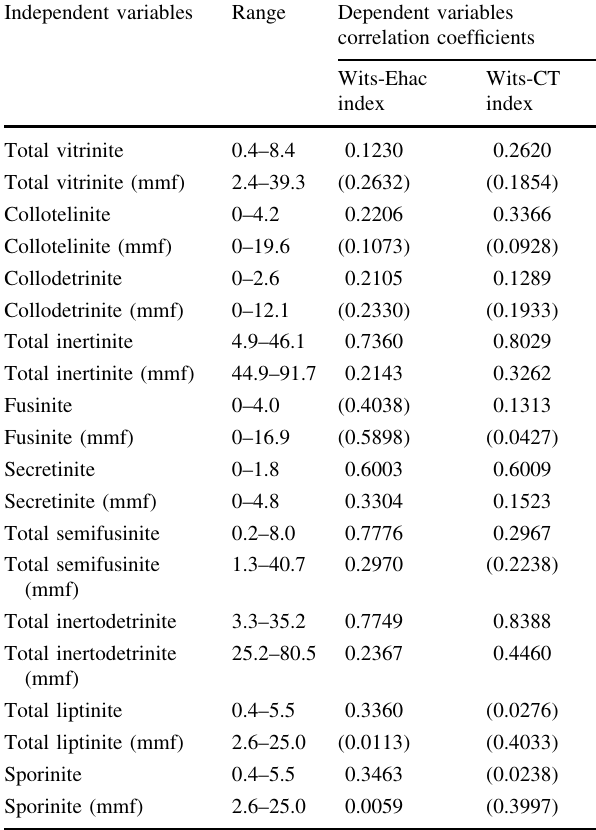
Table 6 Relationships between independent (petrographic analysis- vol%) and dependent variables for coal-shale